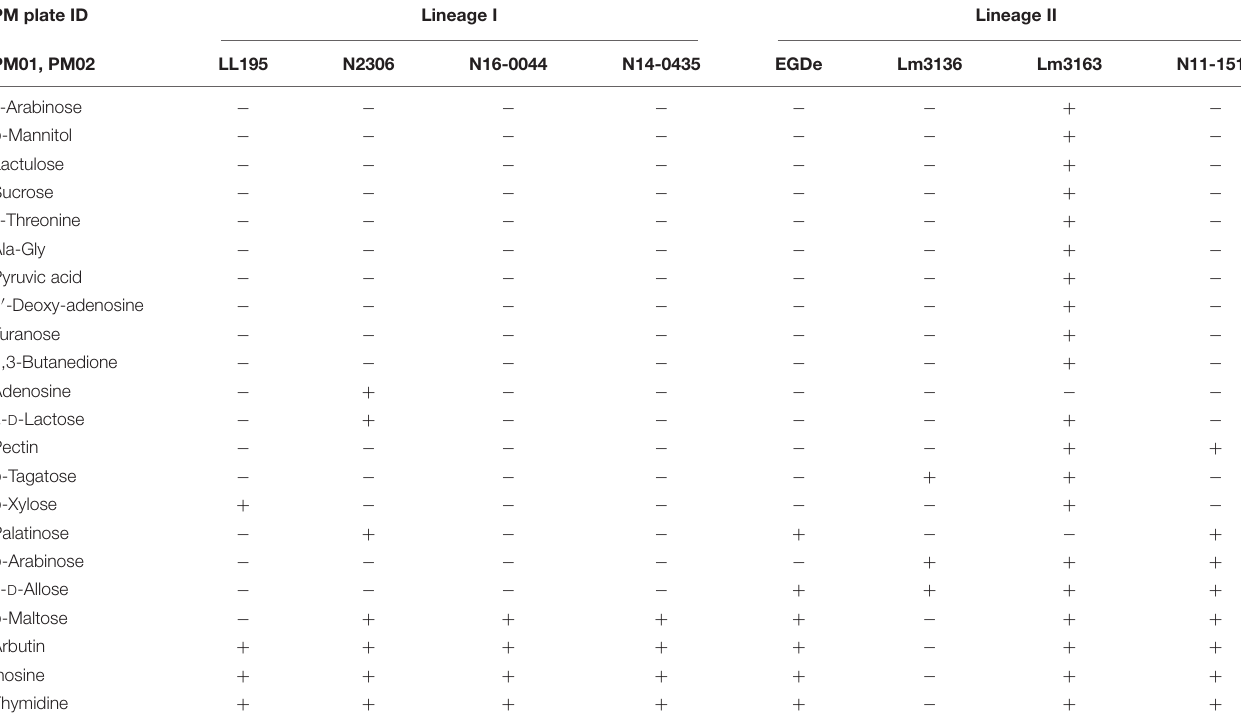
TABLE 3 | Variation in carbon source utilization among the examined L. monocytogenes strains 1 . PM plate ID Lineage I Lineage